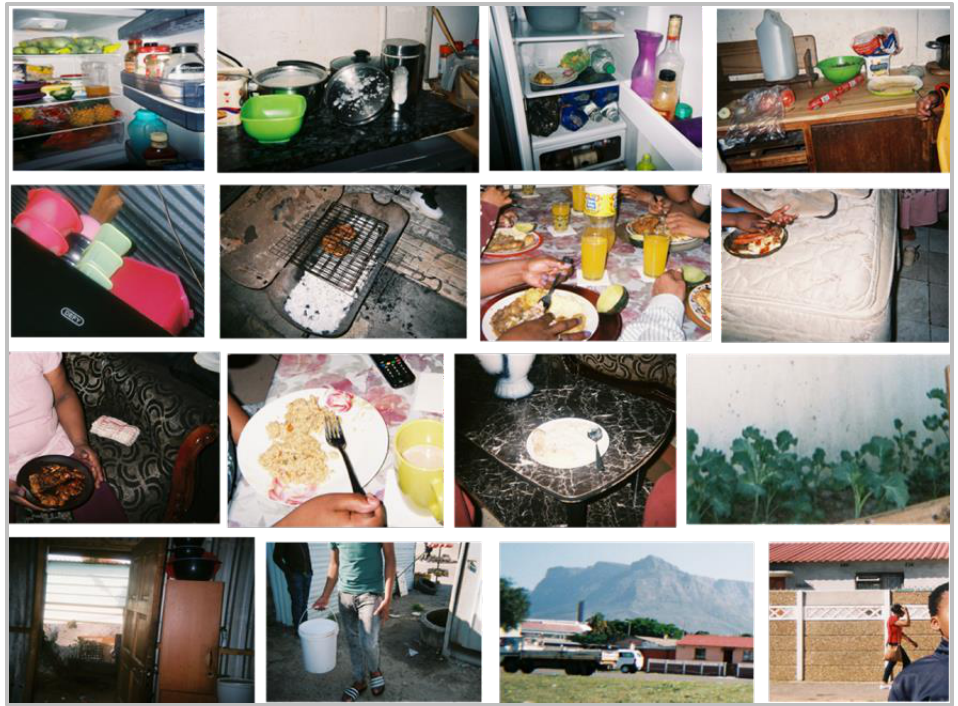
Figure 7. Photographs taken by grade seven learners of household cooking and food storage facilities, meal eating occasions/locations and areas outside their homes, including a vegtable garden where “covo” was grown .